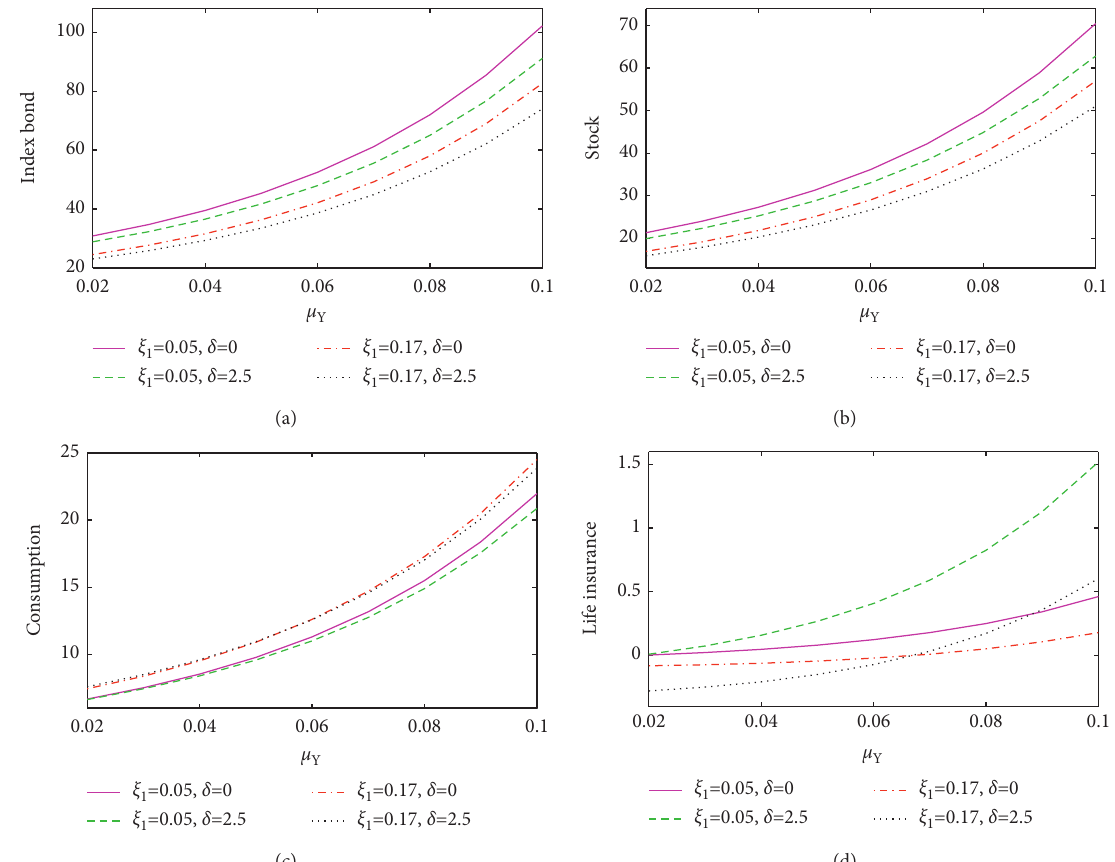
Figure 6: The effects of the expected growth rate of income on the optimal